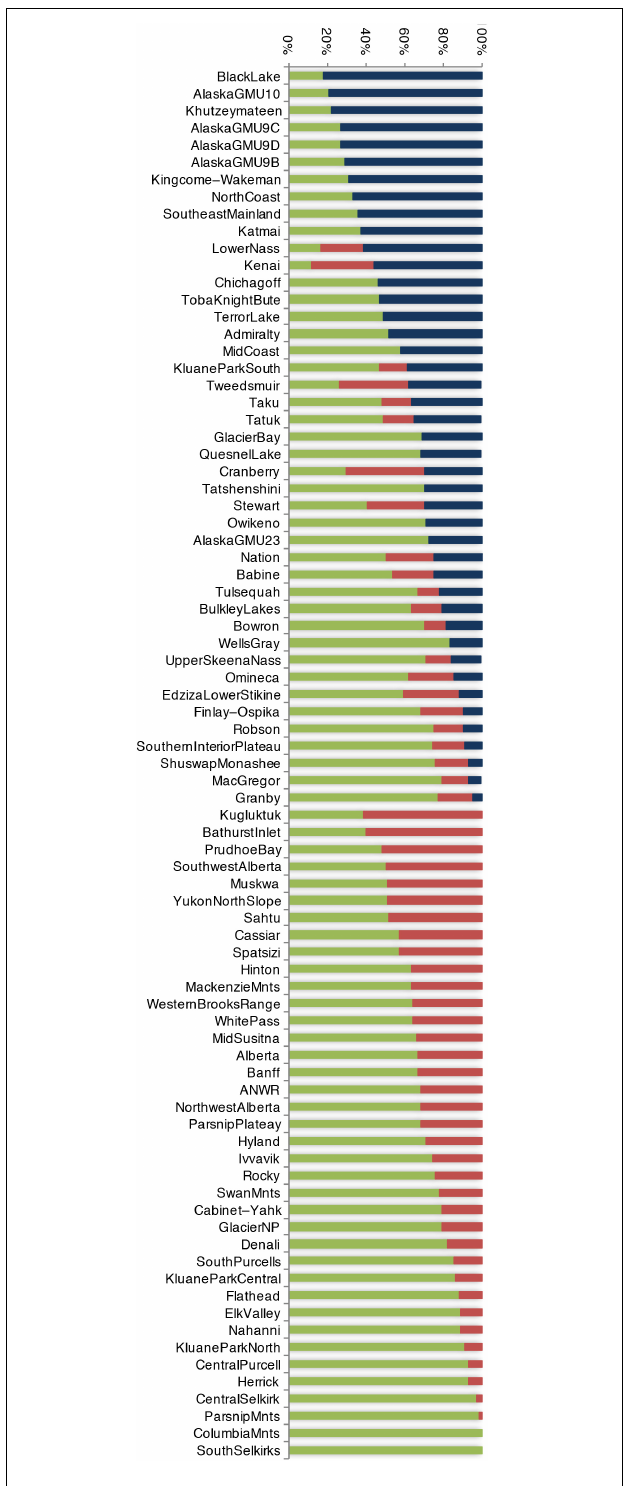
FIGURE 5 | Percent salmon (blue), vegetation (green), and terrestrial meat (red) in the diet of 81 brown bear populations as indicated by stable isotope analysis. Some bears feed primarily on salmon, others primarily on vegetation, and some contain substantial terrestrial meat. Data originally compiled by Mowat and Heard